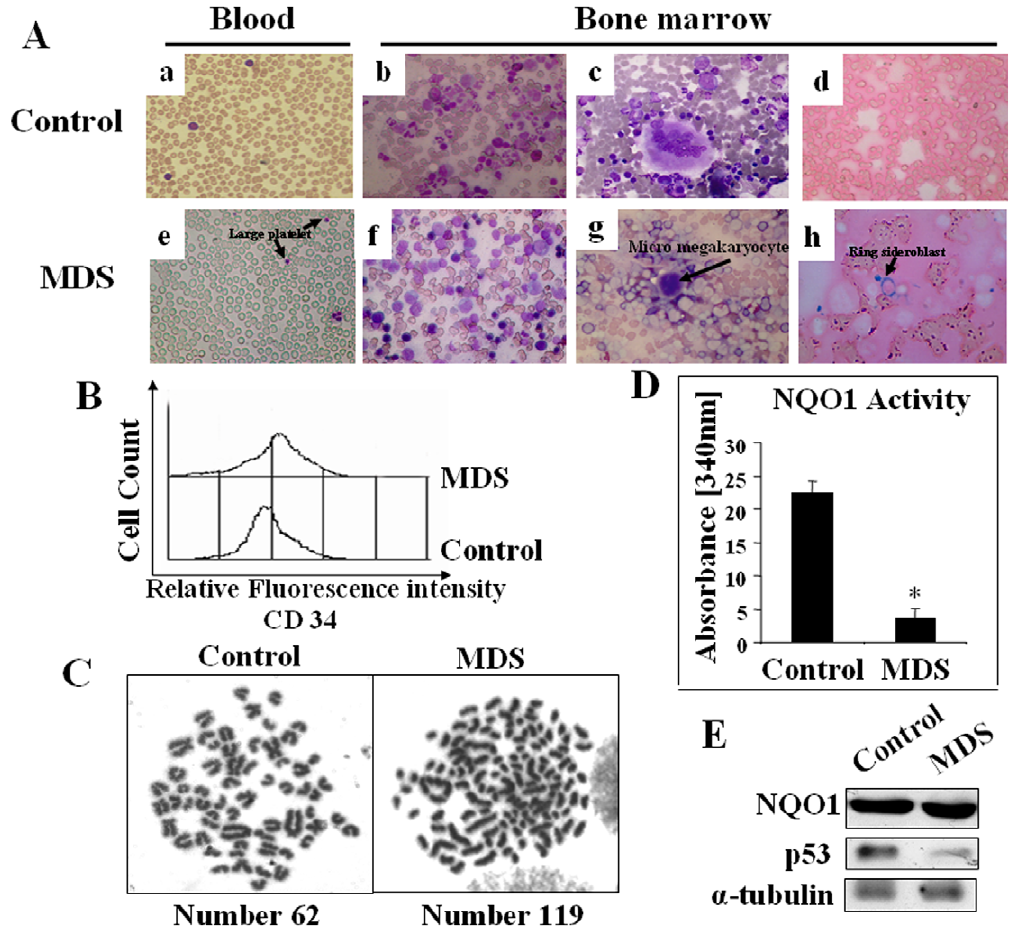
Figure 5. MDS produced in the guinea pigs are irreversible. (Panel A ) Differential staining showing persistent changes in blood and bone marrow cell morphology of MDS guinea pigs followed by discontinuation of CS exposure and feeding 15 mg vitamin C/day. A, a–d , represent sham controls (fed 0.5 mg vitamin C/day and exposed to air); A, e–h , represent MDS guinea pigs followed by discontinuation of CS exposure and feeding 15 mg vitamin C/day. Blood smear - Leishman stain; bone marrow aspirate - Wright Geimsa stain, except Perls’ stain in d and h ; (magnification 400 6 ). (Panel B ) Measurement of CD34( + ) cells in bone marrow by flow cytometry. (Panel C ) Geimsa-stained metaphase spread showing aneuploidy in MDS guinea pigs followed by discontinuation of CS exposure and feeding 15 mg vitamin C/day; (magnification 1000 6 ). (Panel D ) NQO1 Activity of bone marrow cells. Bars over the respective columns represent means 6 SD (n=4); * indicates significant difference (p , 0.05, n=4) with respect to air exposed guinea pigs. (Panel E ) NQO1 and p53 status in the bone marrow cells.